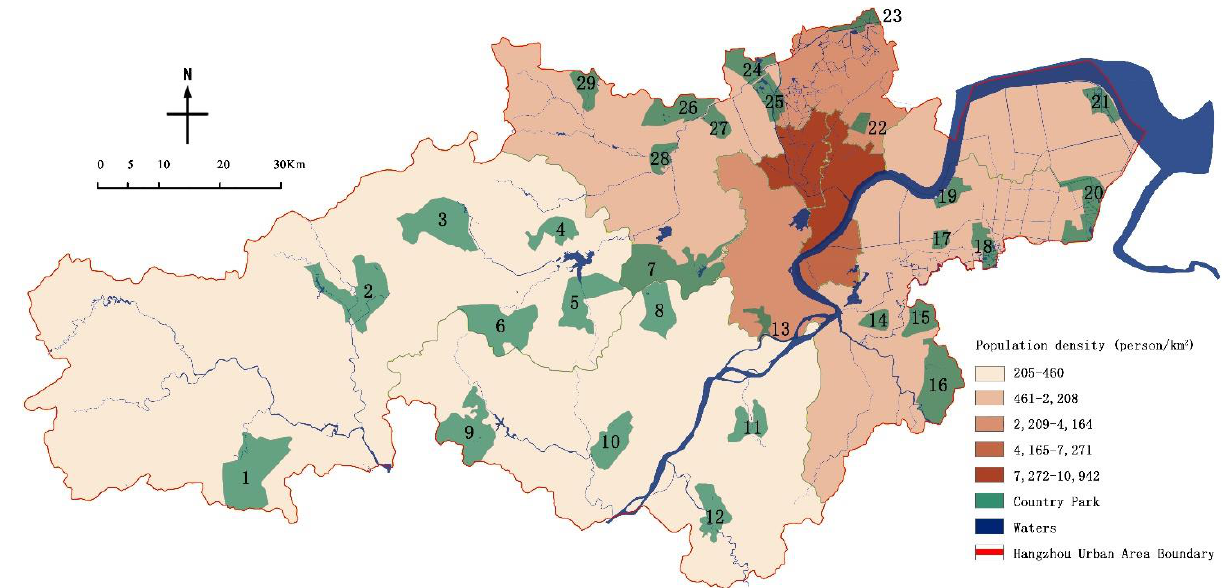
Figure 4. Population density map of Hangzhou.